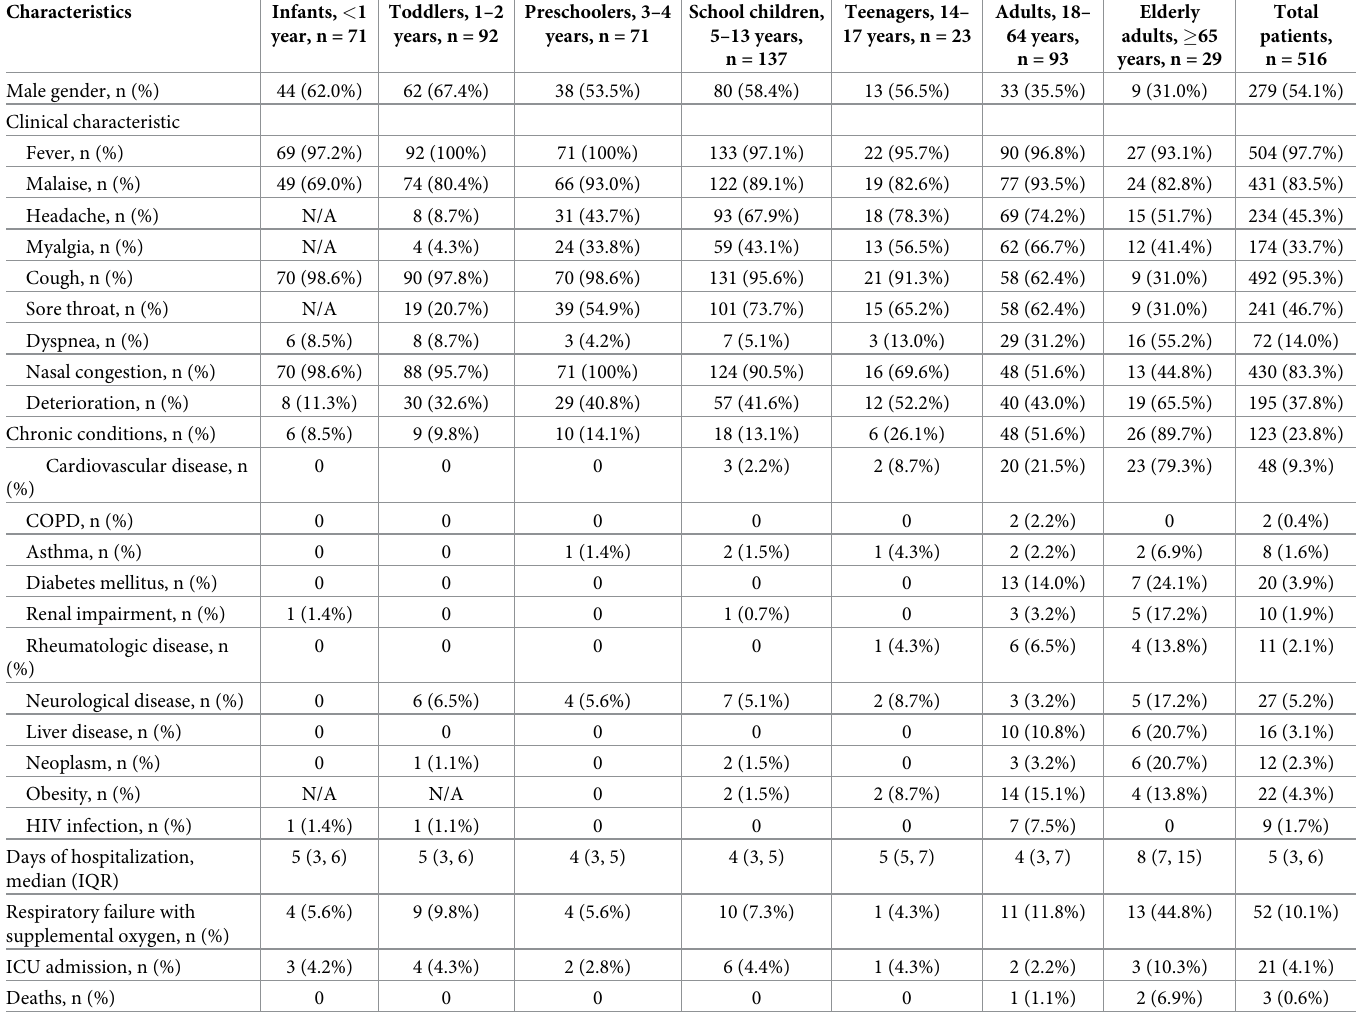
Table 1. Characteristics of patients with laboratory-confirmed influenza by age group.